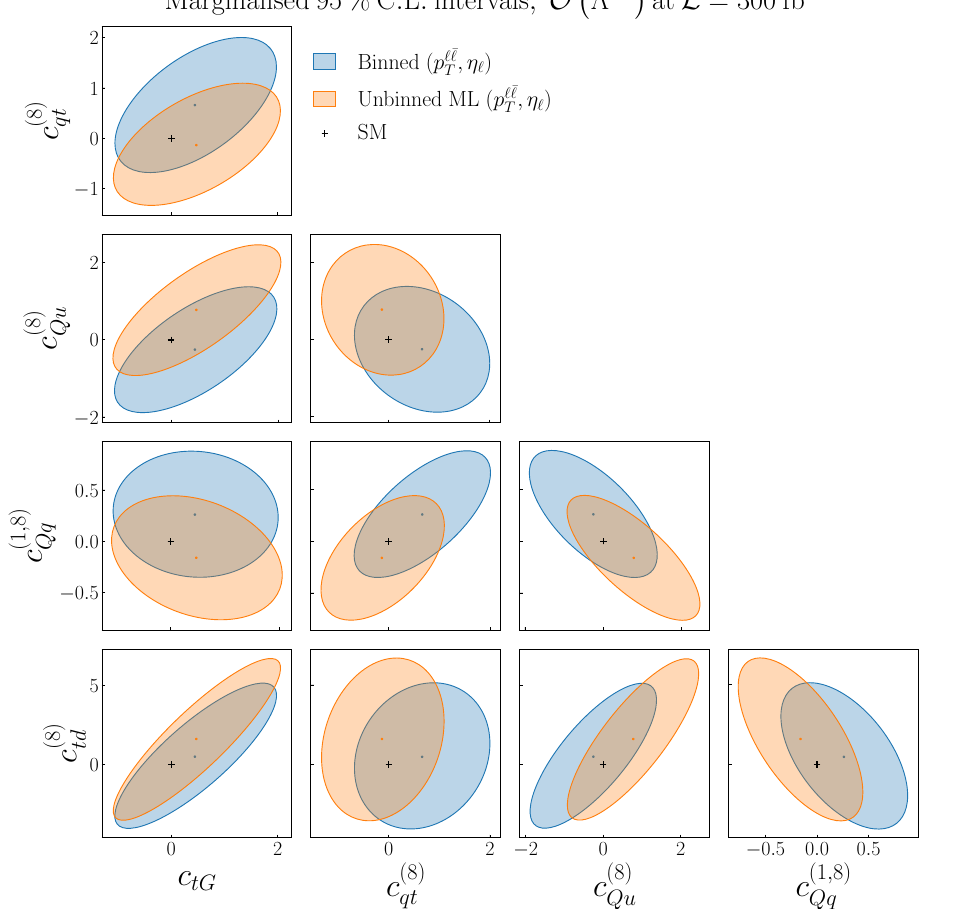
Figure 11. Pair-wise 95% CL contours for the Wilson coefficients entering top quark pair pro- duction in the dilepton final state, see section 4.3 for more details. These contours are obtained by marginalizing over the full posterior distribution provided by Nested Sampling. We consider here n eft = 5 Wilson coefficients that can be simultaneously constrained from inclusive top-quark pair production at the linear level in the EFT expansion. We compare the results obtained from both binned and unbinned ML observables constructed on the ( p ‘ ¯ ‘ figure 10, the black cross indicates the SM values used to generate the pseudo-data that enters the inference. The comparison of the unbinned ML observable trained on ( p ‘ ¯ ‘